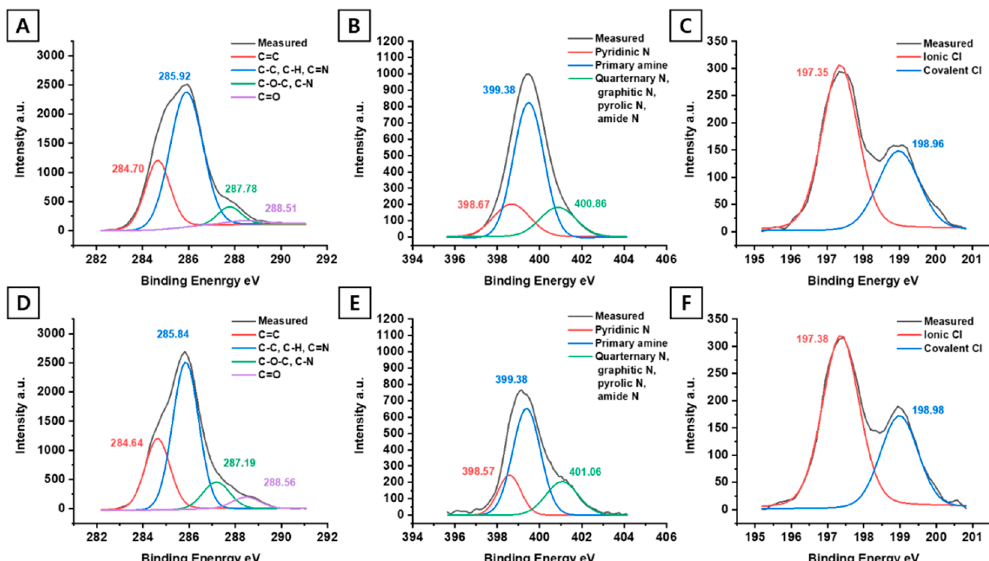
Figure 2. The results of XPS show a clear difference of functional groups on GQPs and GQDs surface. The spectrum of C1s in ( A ) GQPs and ( D ) GQDs can be categorized into 4 groups. The peak intensity is significantly reduced for the COOH group in GQPs with also a visible decrease in the C–O–C intensity. The N1s and Cl2p spectrums of ( B , C ) GQPs and ( E , F ) GQDs show nitrogen and chloride doping and the presence of tertiary amine.